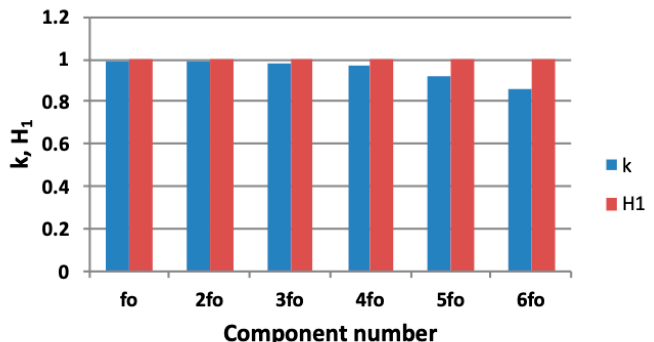
Figure 8. Correlation coe ffi cient k and results of H 1 alternative hypothesis testing (1), that the input